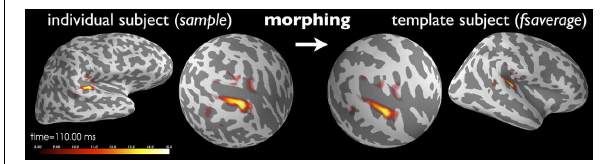
FIGURE 5 | Current estimates obtained from an individual subject can be remapped (morphed), i.e., normalized, to another cortical surface, such as that of the FreeSurfer average brain “ fsaverage ” shown here. The normalization is done separably for both hemispheres using a non-linear registration procedure defined on the sphere (Dale et al., 1999; Fischl et al., 1999). Here, the N100m auditory evoked response is localized using dSPM and then mapped to “fsaverage.” Images were produced with PySurfer .